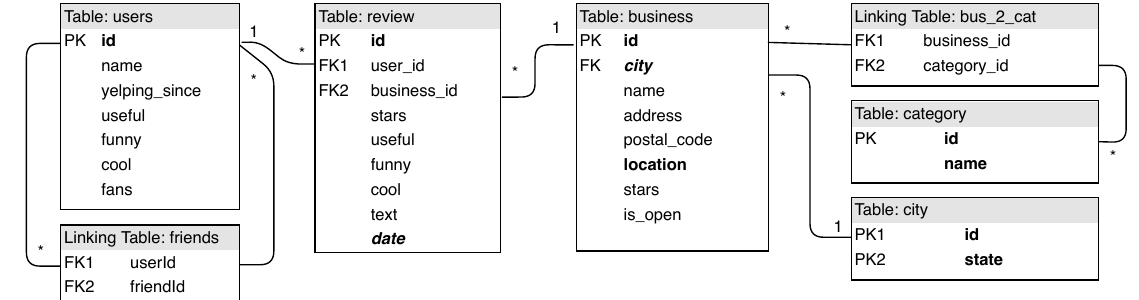
Figure A1. A UML diagram of the relational design of the Yelp dataset. Indexed attributes are in bold whereas clustered attributes are in italics.